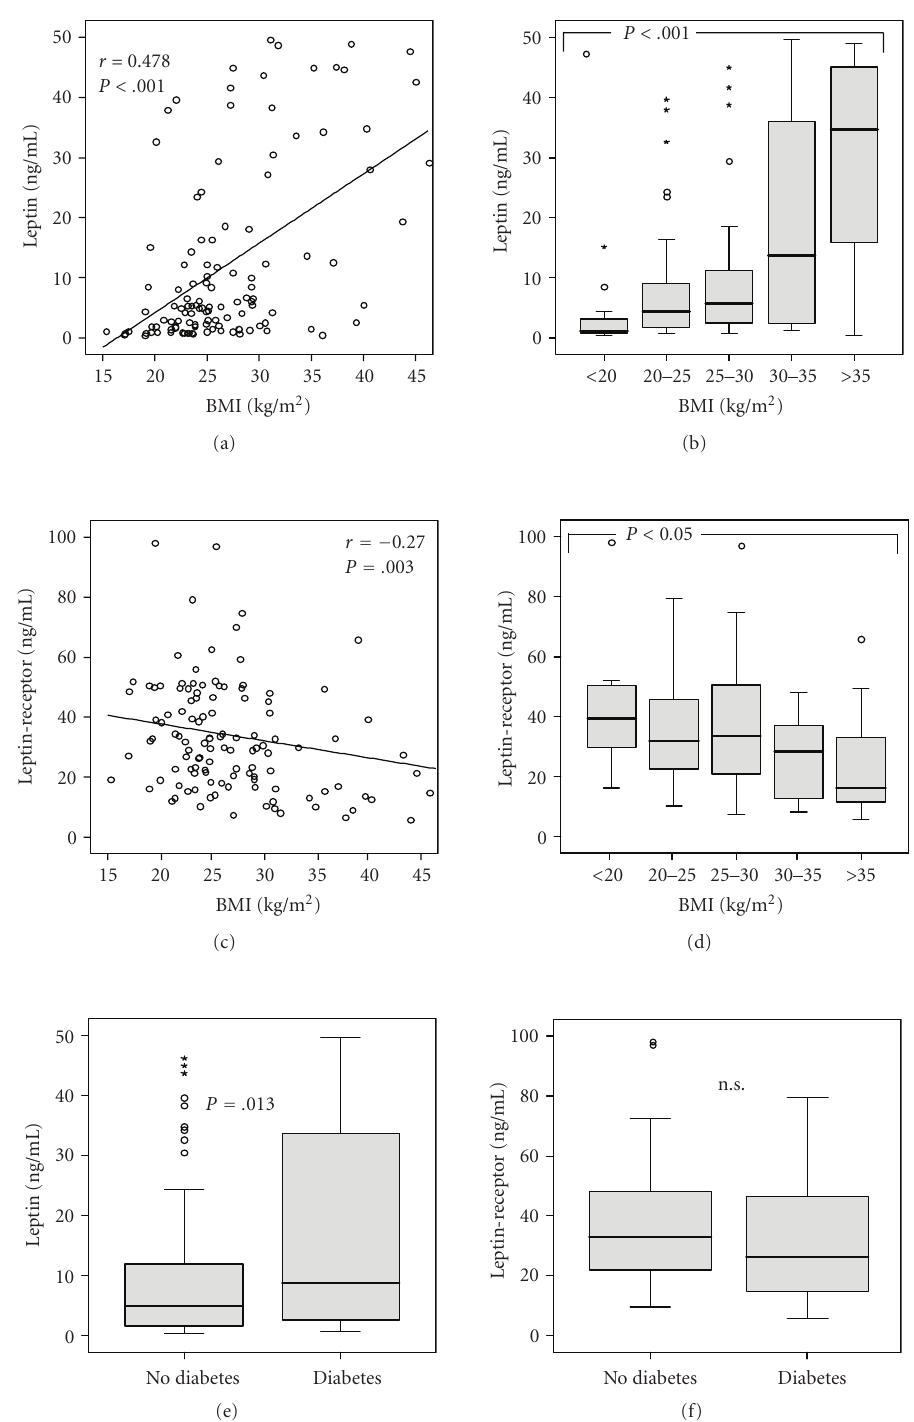
Figure 2: Association of serum leptin and leptin-receptor with obesity and diabetes in critically ill patients. (a) Serum leptin concentrations in ICU patients are correlated with the body-mass index (BMI). Spearman rank correlation test, correlation coe ffi cient r , and P -values are given. (b) Among critically ill patients, serum leptin levels are significantly associated with the patient’s BMI. Box-plot graphics are displayed for di ff erent classes of BMI; Kruskal-Wallis-test is used to assess significance of the di ff erences. (c, d) In line, an inverse association between patient’s BMI or obesity and serum leptin-receptor levels can be detected. (e) Serum leptin is significantly elevated in critically ill patients with preexisting diabetes in comparison to patients without diabetes. (f) Serum leptin-receptor concentrations do not di ff er in critically ill patients with or without diabetes. P -values ( U -test) are given in the figure. Box plot are displayed, where the bold line indicates the median per group, the box represents 50% of the values, and horizontal lines show minimum and maximum values of the calculated nonoutlier values; asterixes and open circles indicate outlier